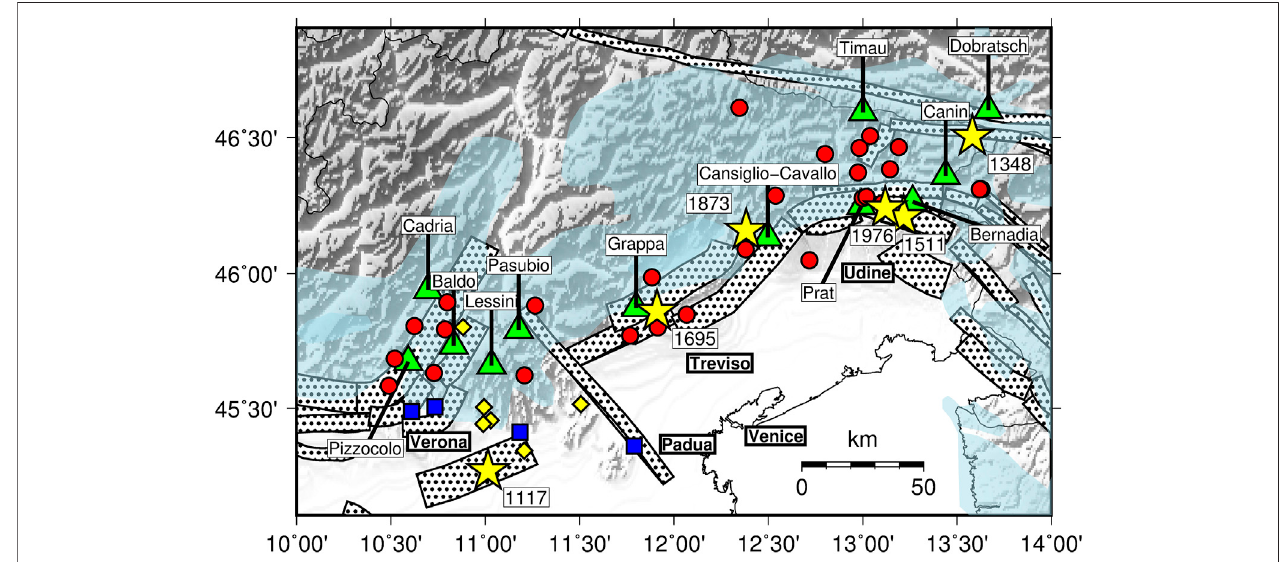
FIGURE3 | Epicenters ofdamaging and destructiveearthquakes located in northeastern Italy (Rovida et al., 2019; Rovida et al., 2020):M ≥ 6.2 earthquakes since 1000 AD (yellow stars) and M ≥ 4.8 earthquakes since 1900 (red circles). The diamonds are alternative epicenters of the 1117 earthquake proposed by various authors, collected by Guidoboni et al. (2005). The dotted areas are the composite seismogenic sources from the DISS database (DISS Working Group, 2018). In light blue the carbonate rock outcrops (http://web.env.auckland.ac.nz/our_research/karst). The triangles are the karst massifs placed by the main clusters of earthquakes. The blue squares are geothermal fi elds fed by meteorological water from karst